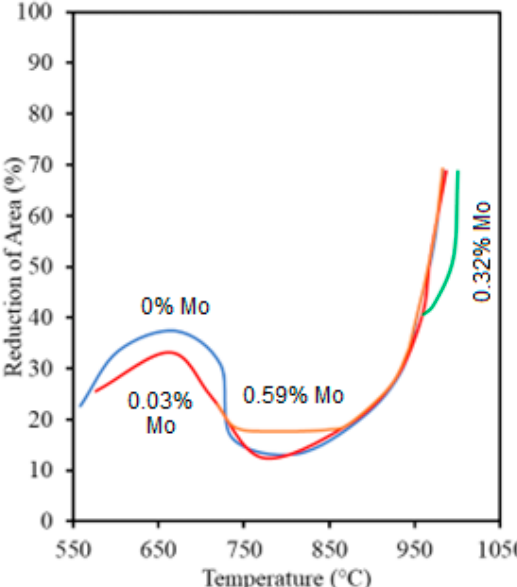
Figure 2. The influence of Mo on the hot ductility of Nb-containing HSLA steels. The steels had the composition of 0.07% C, 0.3% Si, 1.57% Mn, 0.008% P, 0.007% S, 0.037% Nb, 0.039% Al, and 0.015% N and contained nil, 0.03, 0.32, and 0.59% Mo shown as blue, red, brown and green curves, respectively [11].